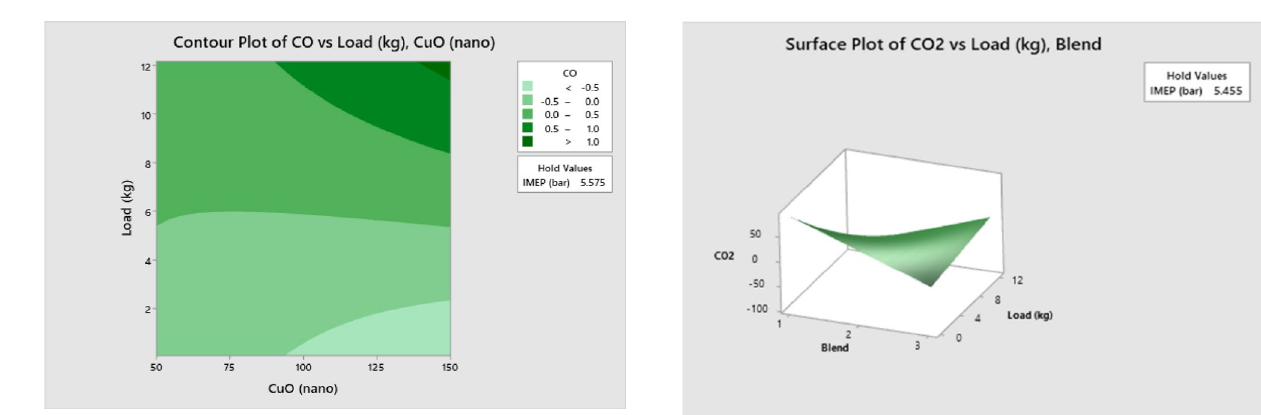
without nanoparticles 2